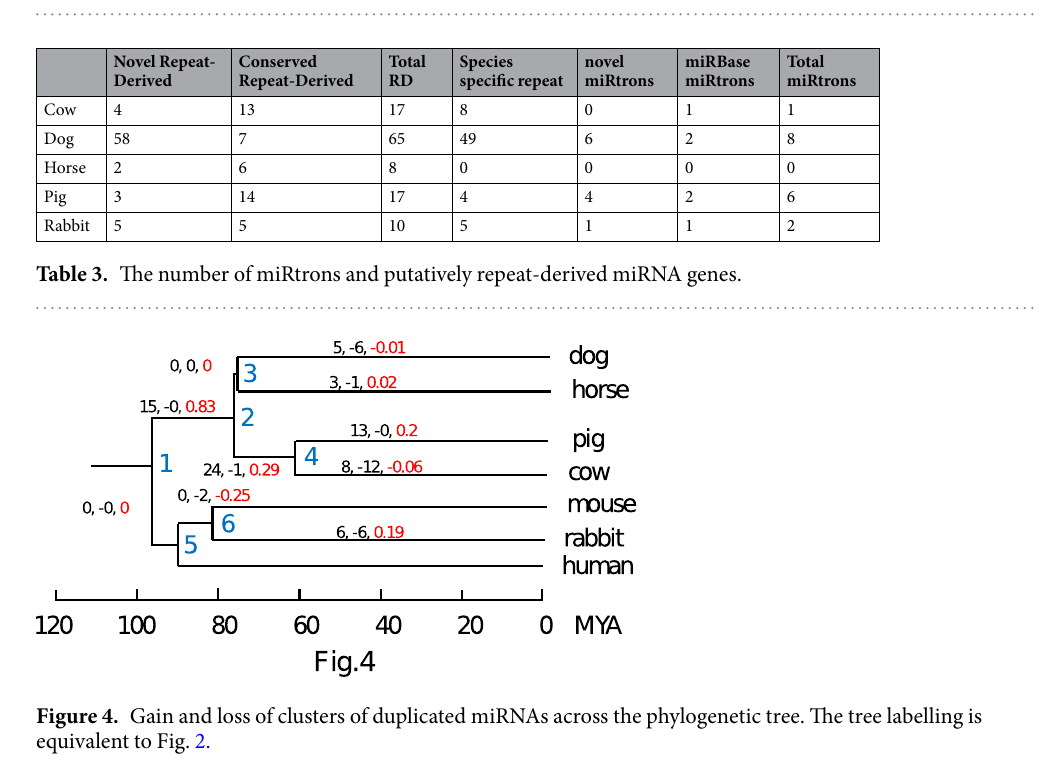
Table 2. The number of reverse complement miRNA gene couples and number of miRNA orthogroups containing paralogous duplicated genes.